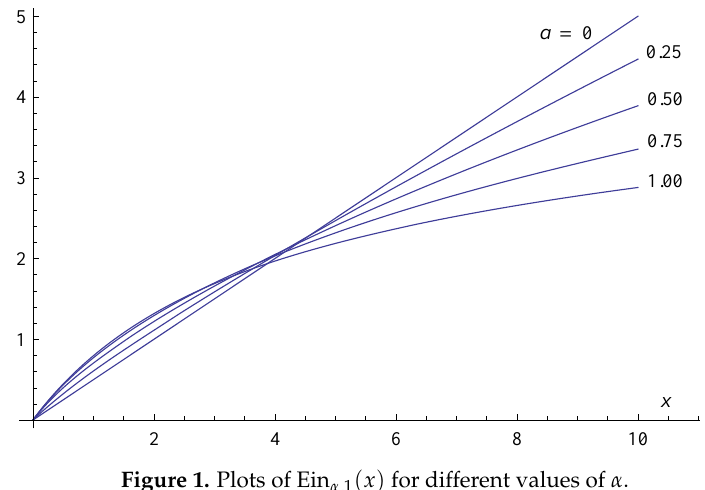
Figure 1. Plots of Ein α ,1 ( x ) for different values of α . Table 1. The absolute relative error in the computation of Ein α , β ( x ) from Theorem 2 for different values of α and x when β =